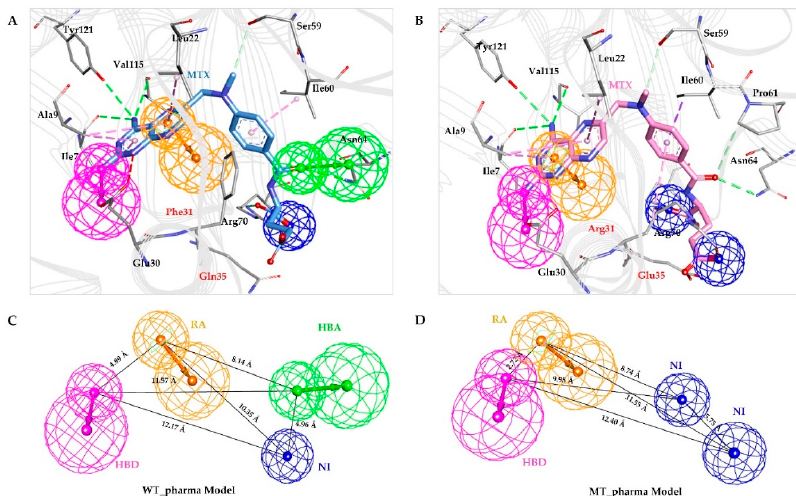
Figure 1. Structure-based pharmacophore generation. ( A ) Residues of wild type hDHFR active site complementing pharmacophoric features are shown as a thin stick. Bound inhibitor (MTX) is shown as a light blue colored thick stick model. HBA, HBD, RA, and NI are colored as green, magenta, orange and blue respectively. ( B ) Residues of mutant hDHFR active site complementing pharmacophoric features are shown as a thin stick. Bound inhibitor (MTX) is shown as a pink-colored thick stick model. HBA, HBD, RA, and NI are colored as green, magenta, orange and blue respectively. ( C ) Interfeature distance illustration of WT-pharma ( D ) Interfeature distance illustration of MT-pharma.